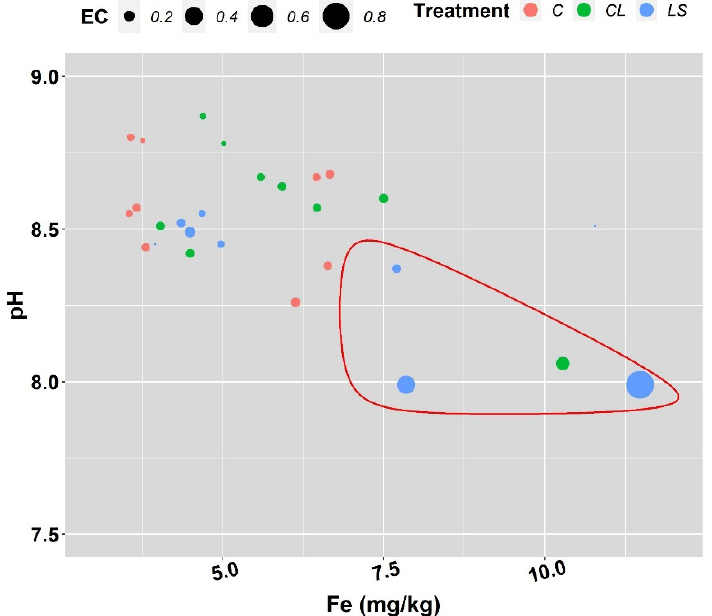
Figure 4. Influence of treatments on soil pH, electrical conductivity (EC in dS/m) and iron (Fe) plant availability. Cases where plant-available Fe was ≥ 7.5 mg/kg and soil pH was ≤ 8.5 are highlighted with a red line. Treatments: control (C), control of leonardite (CL), and leonardite mixed with ferrous sulphate heptahydrate (LS). Table 1. Analysis of variance (ML: Maximum likelihood) performed on the soil parameters (pH, electrical conductivity (EC), soil organic matter (SOM), nitrogen (N), C/N ratio, phosphorus (P), potassium (K), iron (Fe), manganese (Mn), copper (Cu) and zinc (Zn)) at the leaf fall stage. The re ‐ sults were significant at * p < 0.05, ** p < 0.01 and *** p < 0.01. Soil Parameter ML Ratio (Treatment (T)) ML Ratio (Year (Y))